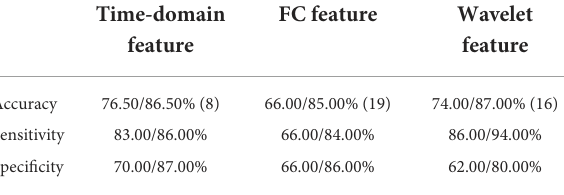
TABLE 4 Comparison of the 10-fold cross-validation results using different features before and after channel